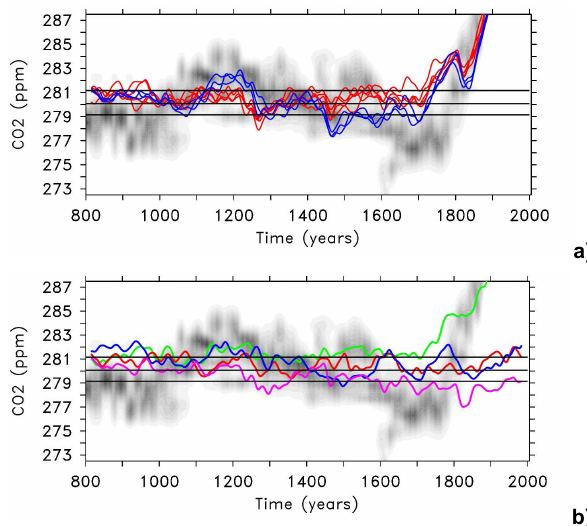
Fig. 6. CO 2 concentrations (31-year running mean) from (a) en- sembles E1 (red) and E2 (blue) in comparison with a compilation of ice core reconstructions (grey shading, see Appendix A). Black horizontal lines denote the control experiment mean and its 5th– 95th percentile range, (b) the respective CO 2 concentrations from the experiments forced by one single component, i.e. standard solar forcing (red), strong solar forcing (blue), land-cover change (green), and volcanic aerosols (purple).